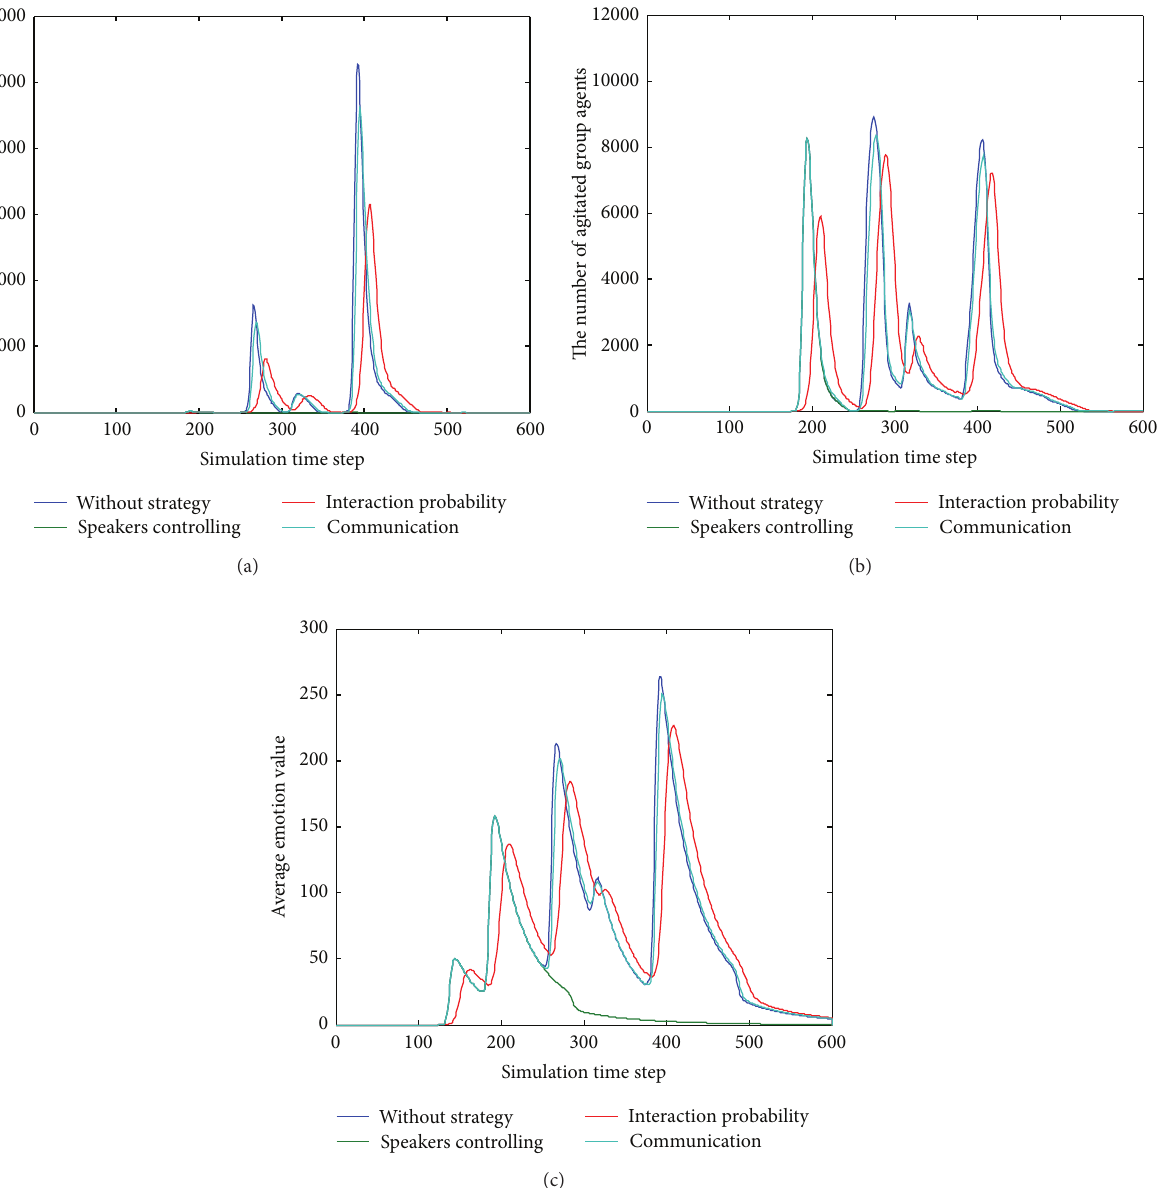
Figure 9: Group emotion evolution of the case incident, (a) the number curves of extreme group agents, (b) the number curves of agitated group agent, and (c) average emotion value evolution curves. (The strategies were taken at simulation step